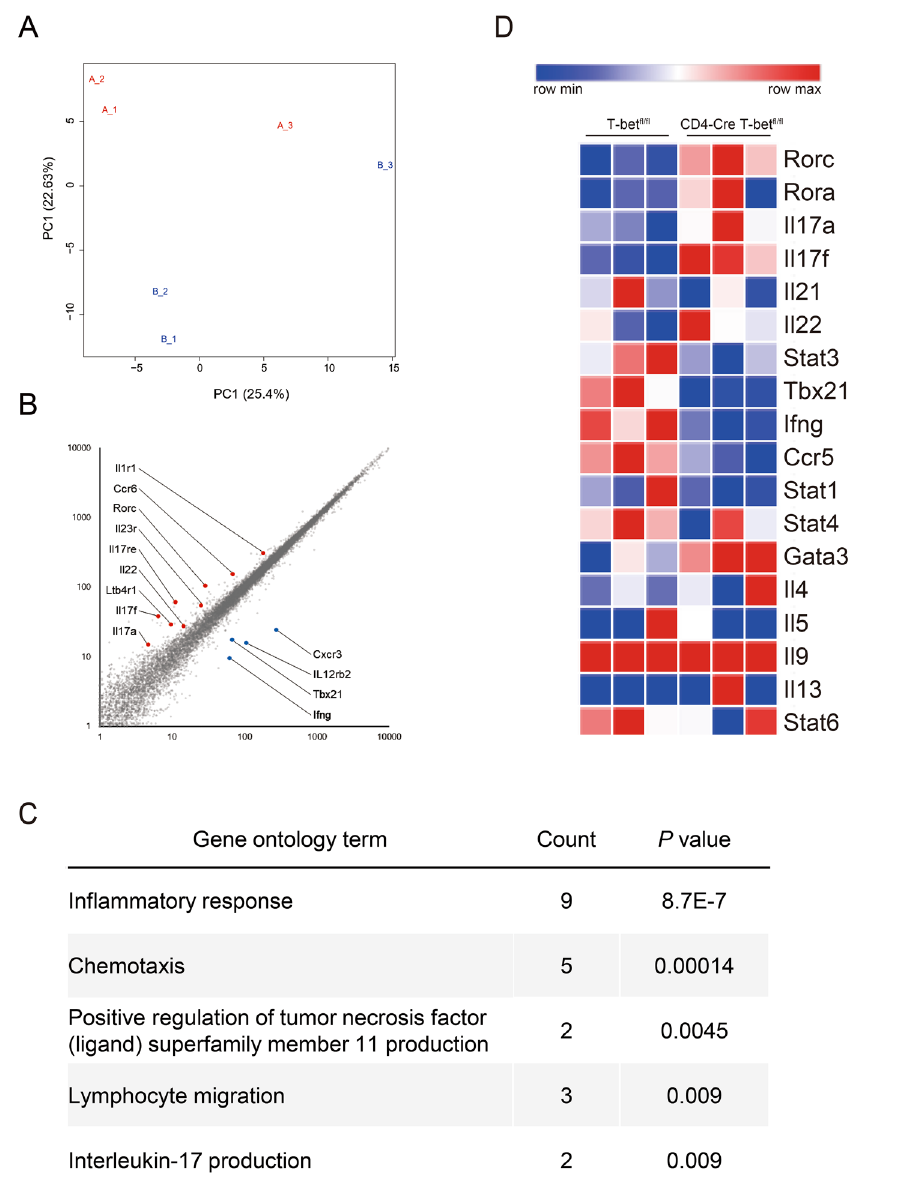
Figure 6. RNA sequencing revealed T-bet selectively inhibited expression of Th17 cell-related genes, but not other subsets of CD4 + T cells. At day 10 post first immunization with CII, CD4 + T cells were isolated from the draining LNs of T-bet fl/fl mice (n = 3) and CD4-Cre T-bet fl/fl (cKO) mice (n = 3) and the transcriptome was analyzed. ( A ) Principal component analysis of RNA-seq data. Each point represents one sample with blue points indicating T-bet fl/fl mice and red points cKO mice. ( B ) Scatter plot. ( C ) GO analysis of genes differentially expressed in CD4 + T cells from T-bet fl/fl and cKO mice. ( D ) Heatmap of Th cell signature